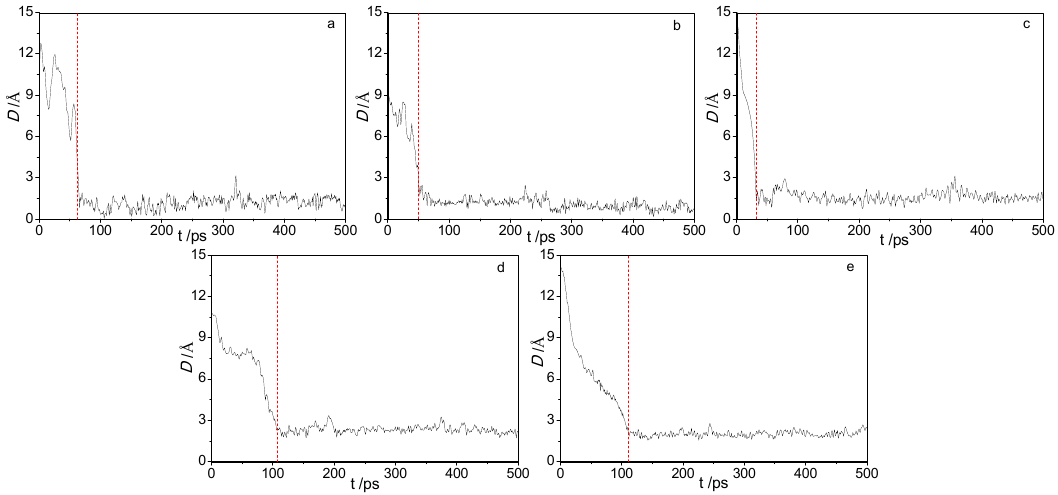
Figure 1. The distances of the centroids of five acid molecules from the surface as a function of simulation time. ( a ) Formic acid; ( b ) Acetic acid; ( c ) Levulinic acid; ( d ) Naphtenic acid; ( e ) Stearic acid.